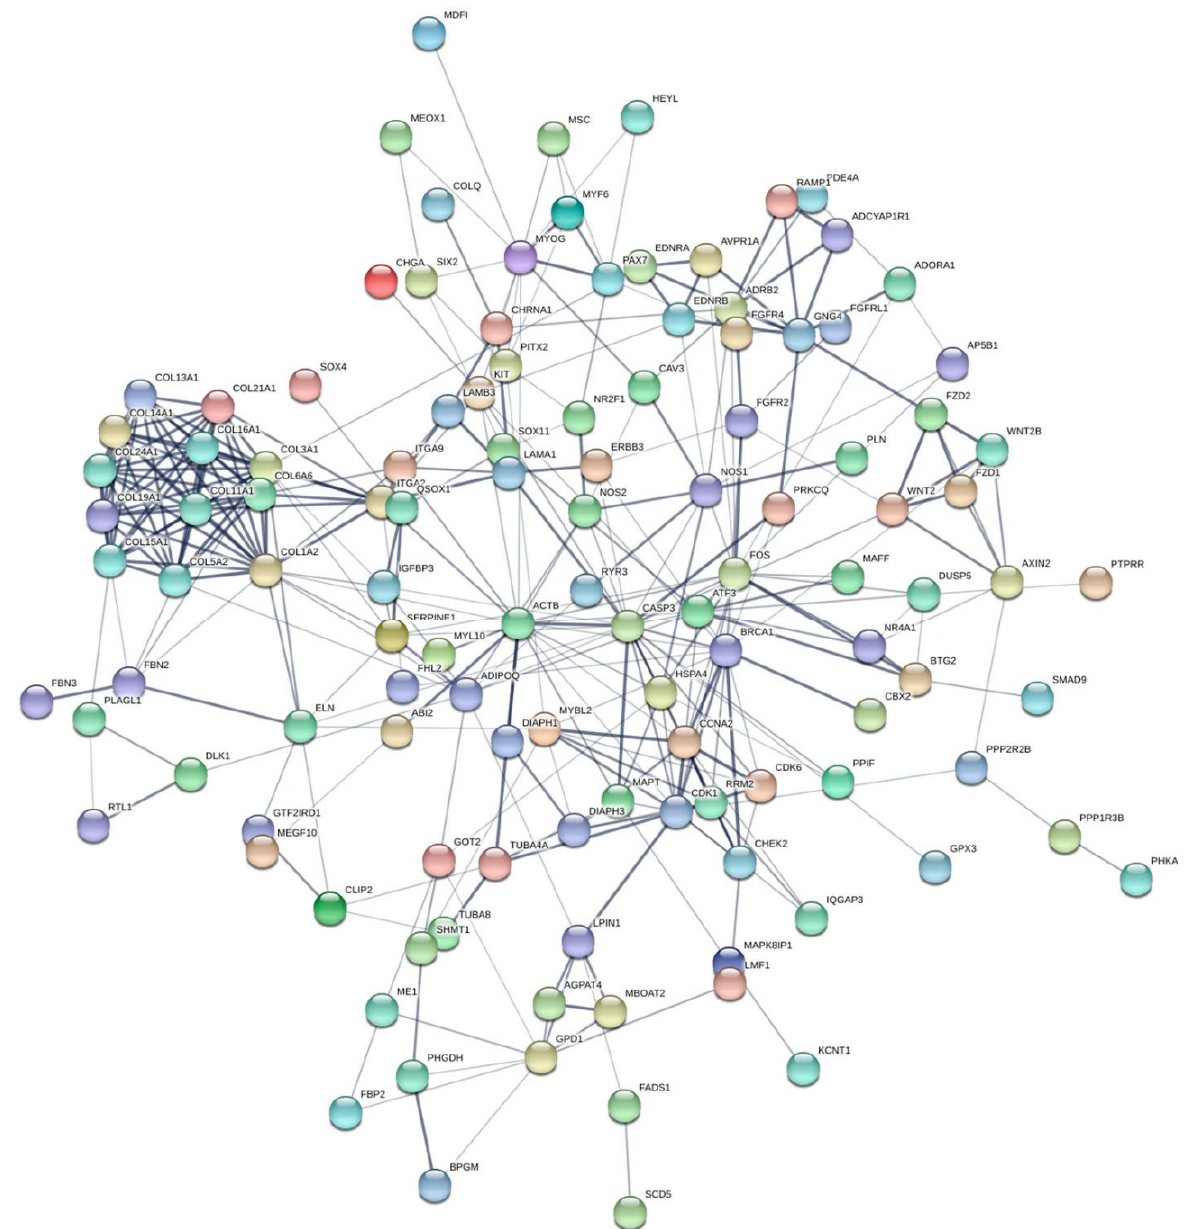
Figure 3. The network of differentially methylated genes associated with muscle development in sheep. Darker lines indicate higher confidence levels [131].